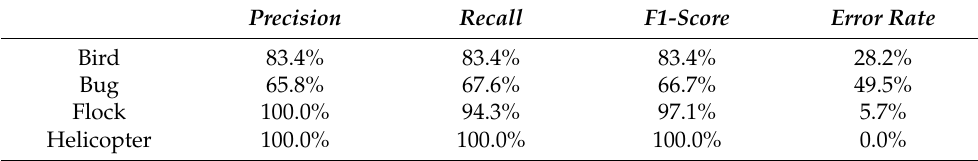
Table 5. Comparing the precision , recall , F1 score, and error rate between the individual classes. Precision